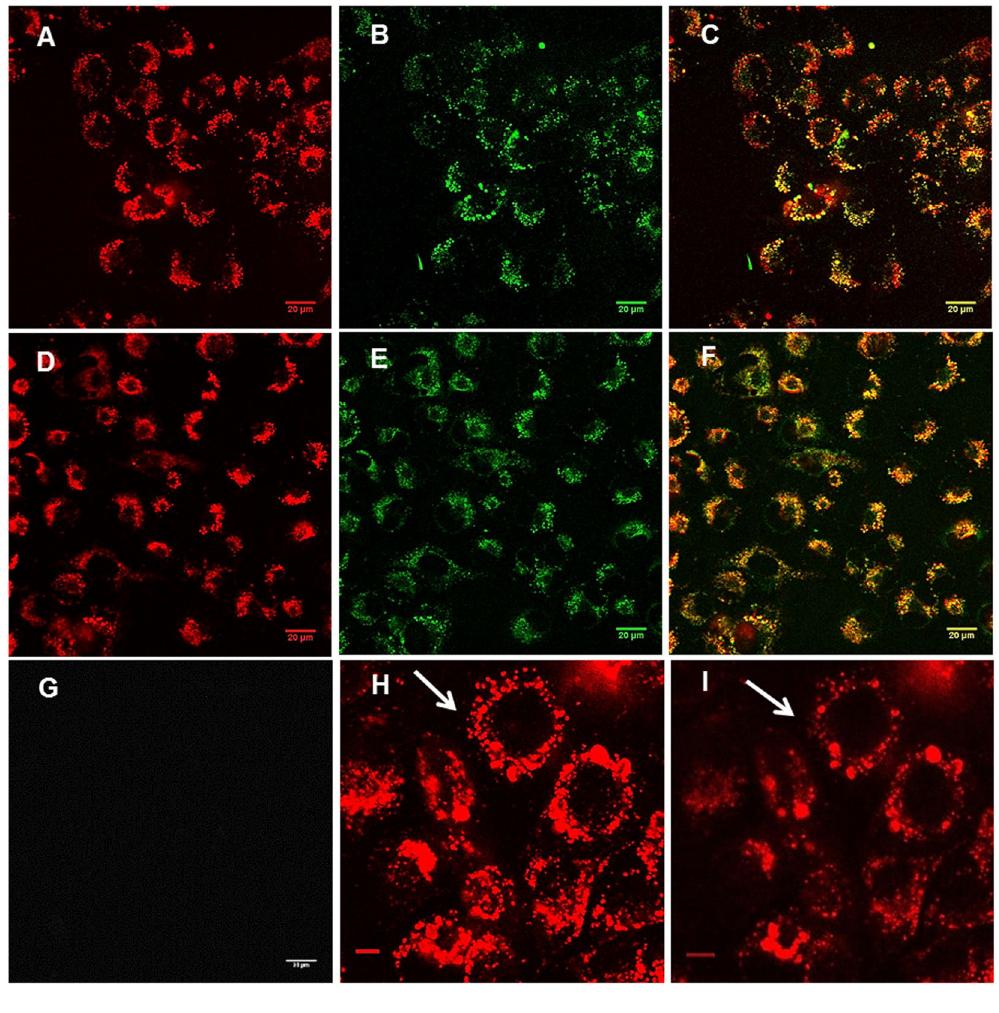
Figure 3. Cellular uptake and colocalisation of the conjugates with LysoTracker Green in MC28 cells using laser scanning confocal microscopy. Cells were incubated with the conjugates for 24 h. LysoTracker Green was applied to cells 30 minutes before imaging. ( A ) Conjugate 7 alone (red), ( B ) LysoTracker Green (green), ( C ) merged ( A and B) . Scale bar: 20 μ m; ( D ) conjugate 8 alone (red), ( E ) LysoTracker Green (green), ( F ) merged ( D and E ). Scale bar: 20 μ m; ( G ) MC28 cells following incubation with unconjugated chlorin e 6 . Scale bar: 20 µ m; ( H and I ) Cellular fluorescence of conjugate 7 ( H ) measured initially, and ( I ) after prolonged on-stage laser illumination at 405 nm. Arrows highlight areas where fluorescent vesicles initially observed are absent following laser illumination. Scale bar: 5 µ m.